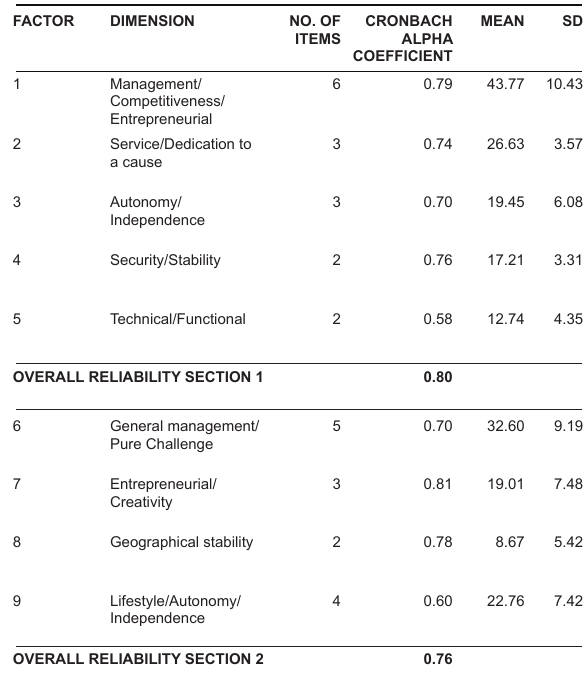
EFA: Descriptive statistics: Reliability, means, standard